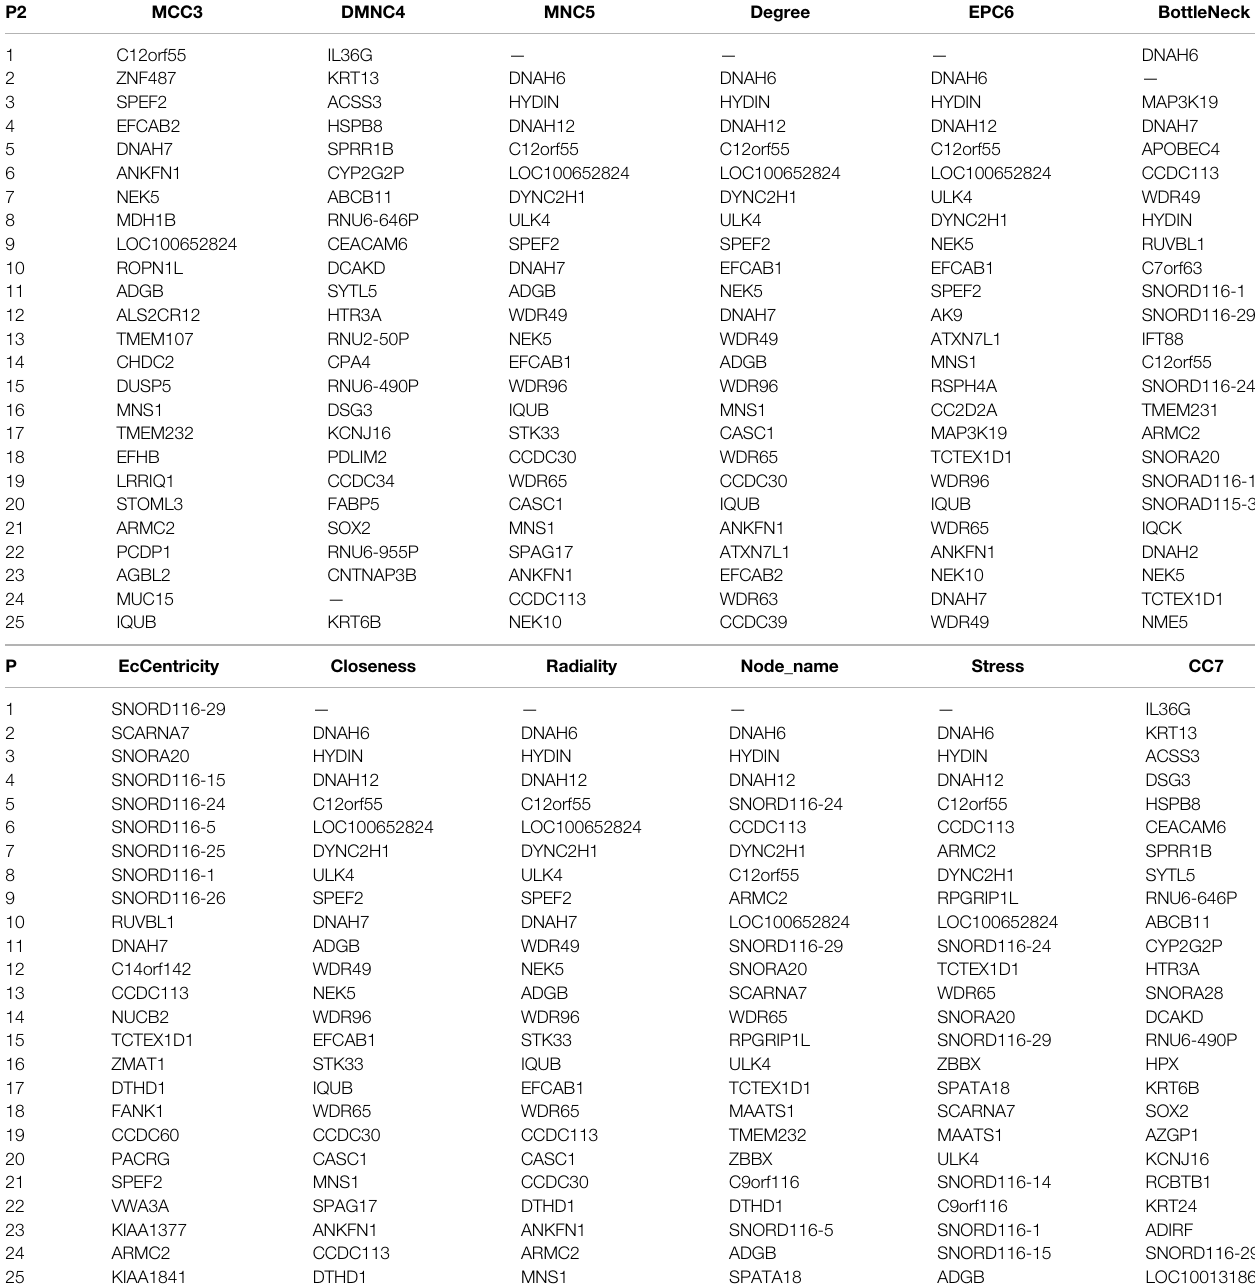
TABLE 1 | Top 25 hub genes of the blue module through dataset 1.